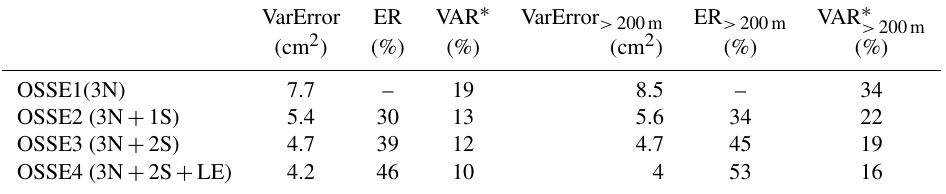
Table 4. Ocean analysis statistics considering the SSH fields during the year 2009. Column 1 represents the ocean analysis variance of error with respect to the NR (VarError; cm 2 ). Column 2 represents the reduction of the variance of the error in the ocean analysis (ER; %), with respect to OSSE1 (3N). Column 3 shows the ratio of the variance of the error in each experiment and the variance of the SSH signal in the NR (VAR ∗ ; %). Columns 4–6 are the same as columns 1–3, but exclude the shelf areas shallower than 200m (e.g. ER > 200m ; %). The abbreviations in parentheses are defined in the caption of Table 3. VarError ER VAR ∗